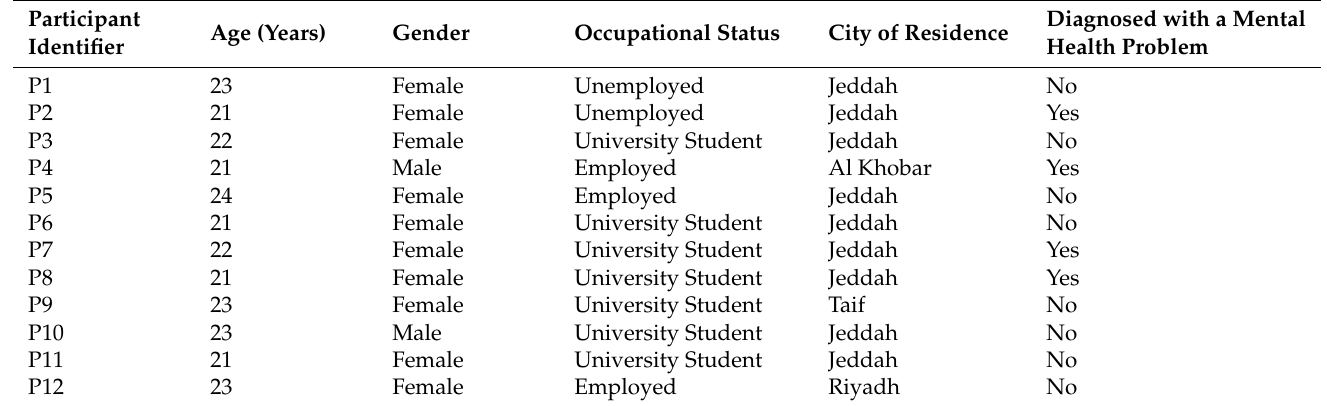
Table 1. Participants’